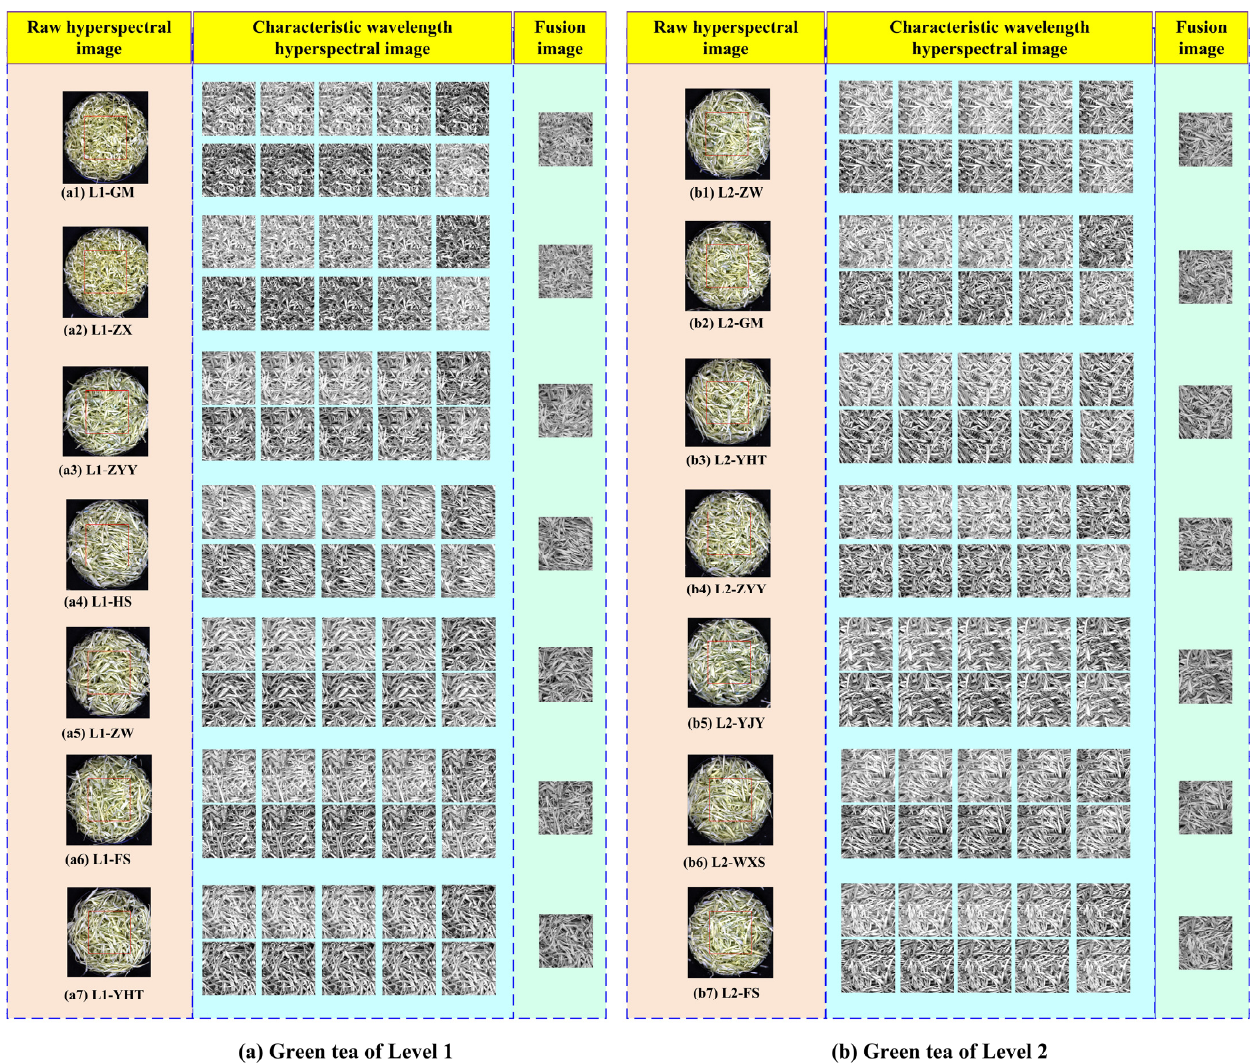
Figure 6. Ten hyperspectral images corresponding to characteristic wavelengths of different tea samples and their fusion images. Among them, hyperspectral images of 10 characteristic wavelengths are obtained from the original hyperspectral image of each tea sample, including the wavelengths from left to right in the first row are 944 nm, 951 nm, 1067 nm, 1104 nm, 1376 nm, and the second row is 1425 nm 1582 nm, 1655 nm, 1685 nm, 1688 nm, and then generate fusion image from ten wavelength images.